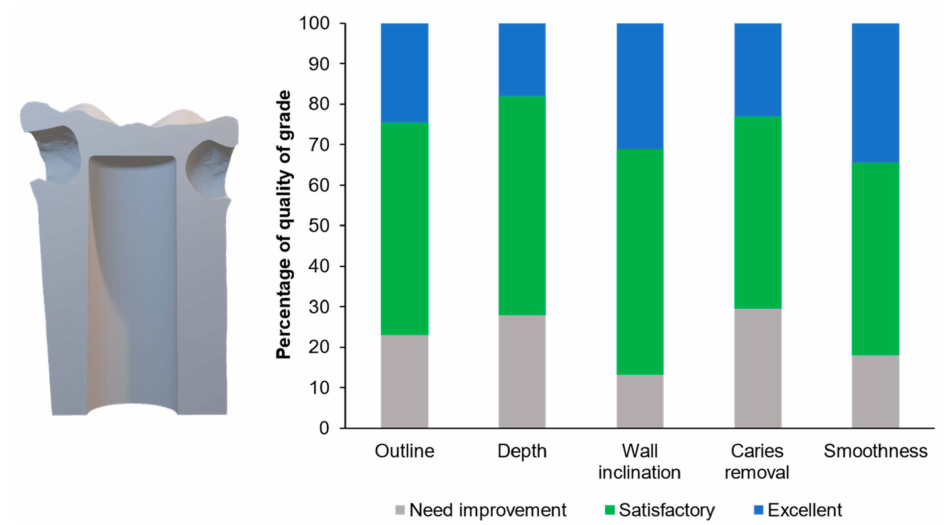
Figure 8. Percentage of grades for each parameter evaluated for the proximal cavity